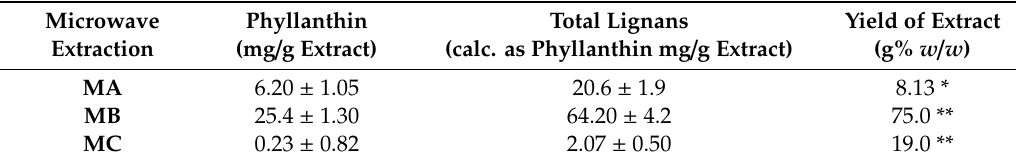
Table 3. Contents of phyllanthin and total lignans in the methanol extract and fractions of P. niruri using microwave-assisted extraction (MAE).